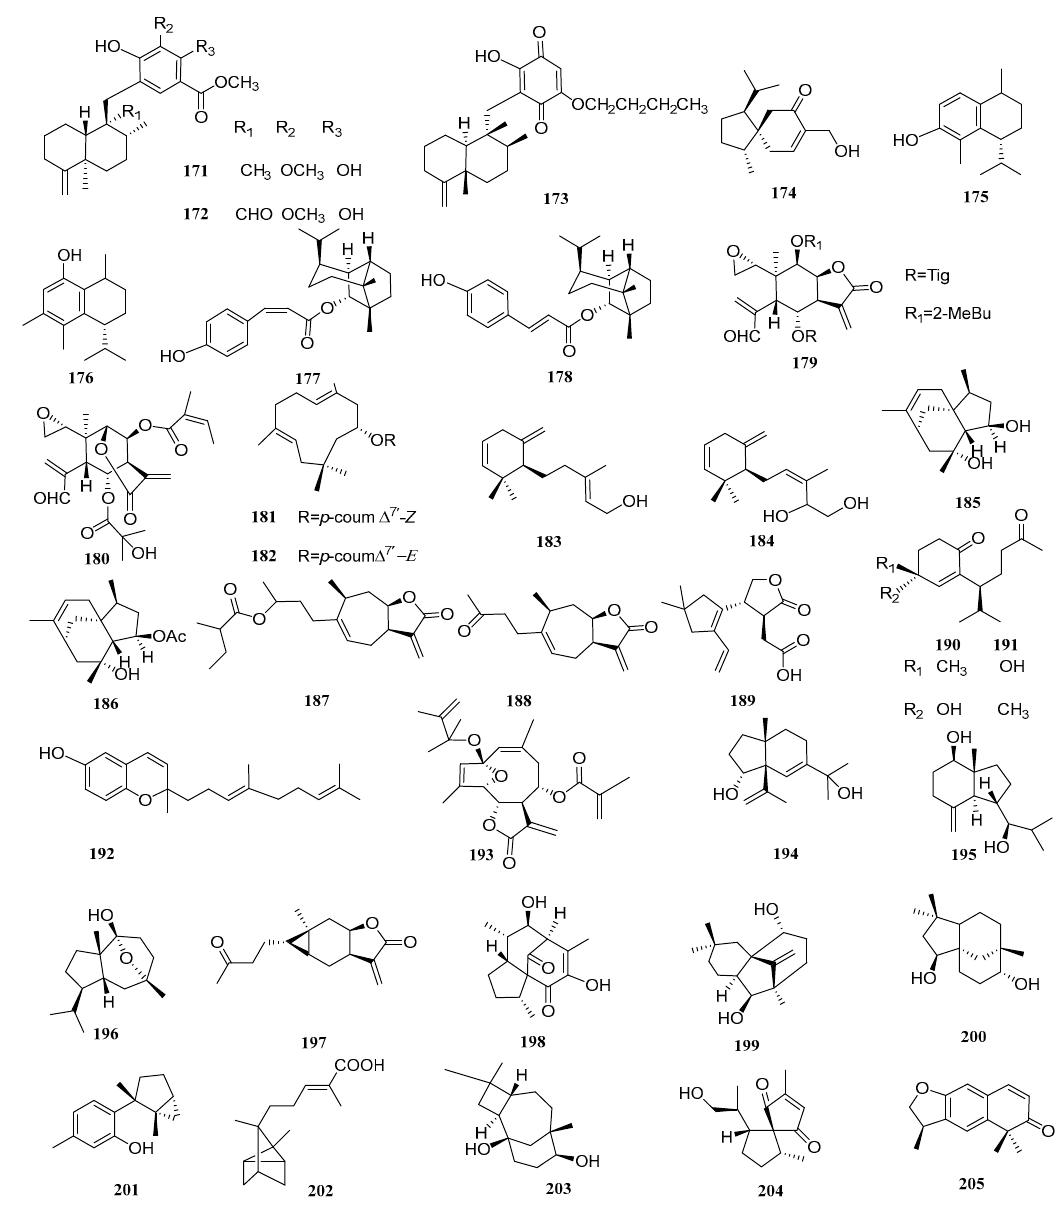
Figure 22. Structures of sesquiterpenoids 171 – 205 of other